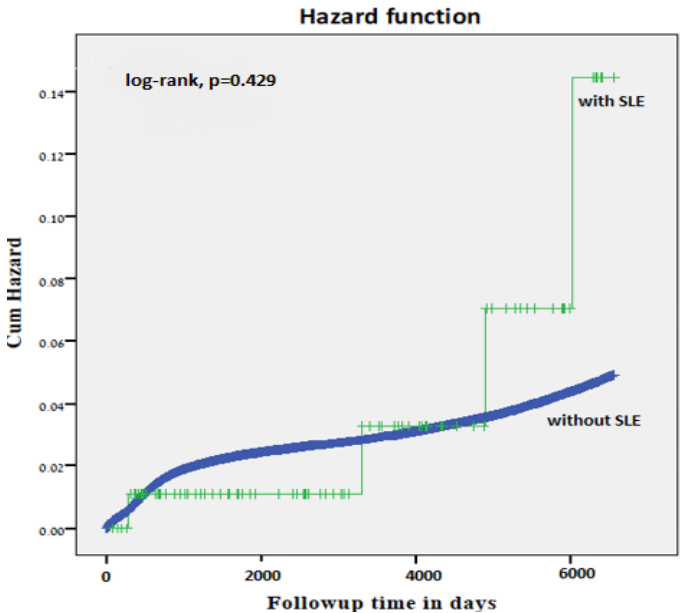
Figure 1. Kaplan-Meier survival curve demonstrating the cumulative incidence of neurologic-related hospitalizations in offspring of mothers with and without SLE (log-rank test, p = 0.429).